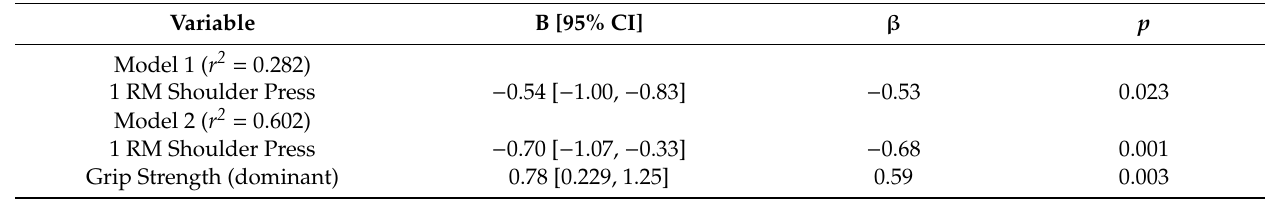
Table 4. Unstandardized (B) and standardized ( β ) regression coe ffi cients for each predictor